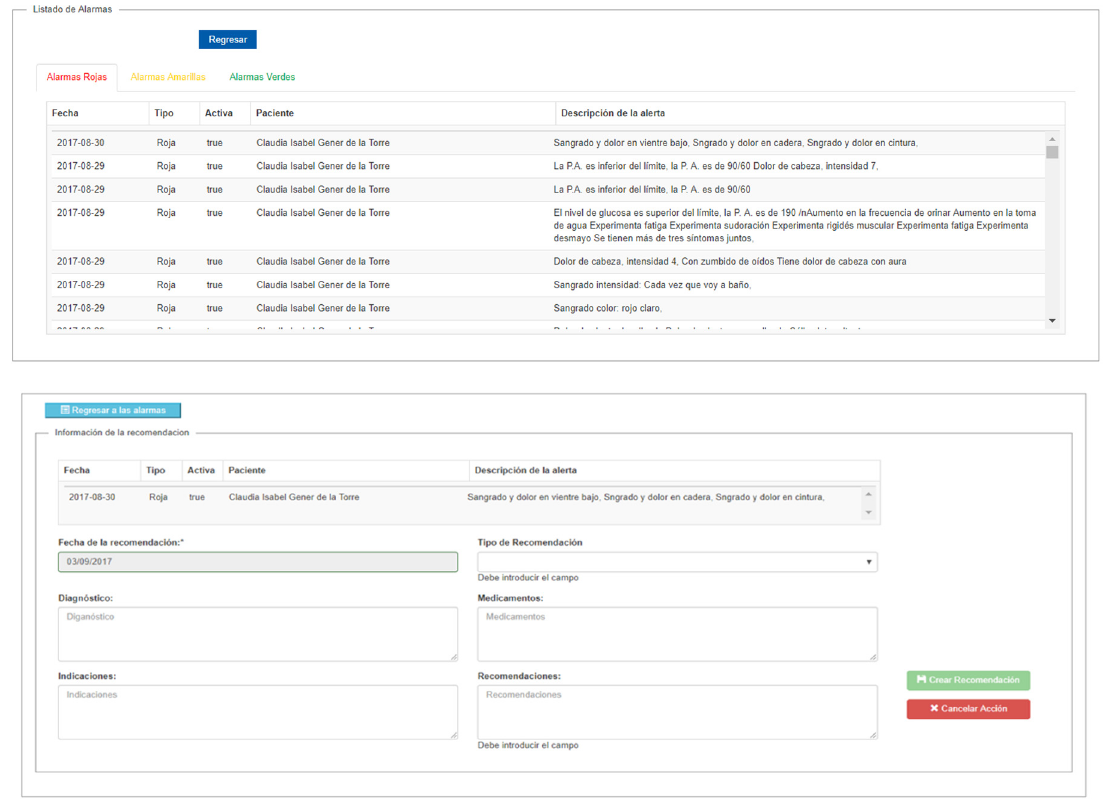
Figure 3. List of medical alarms generated by patients and medical recommendation edition.